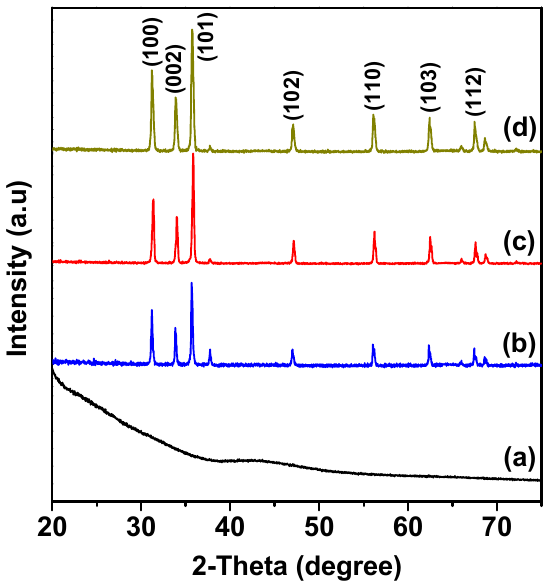
Figure 1. X ‐ ray diffraction patterns of ( a ) PZ ‐ 0, ( b ) PZ ‐ 9, ( c ) PZ ‐ 17, and ( d ) PZ ‐ 19. Figure 1. X-ray diffraction patterns of ( a ) PZ-0, ( b ) PZ-9, ( c ) PZ-17, and ( d )